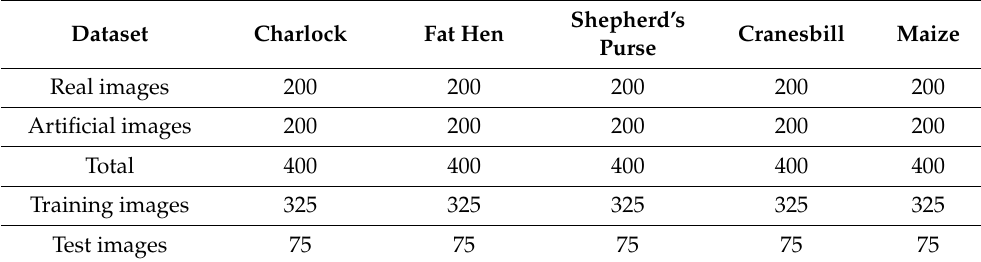
Table 2. Summary of data distribution for each class.